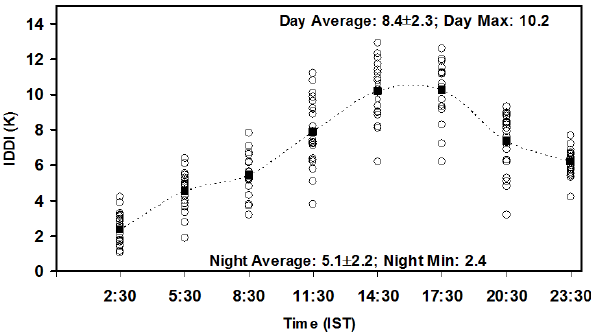
Fig. 3. Diurnal variation of IDDI observed over “Thar” desert in In- dia for May 2003. Mean value is shown as solid squares connected by dotted line.